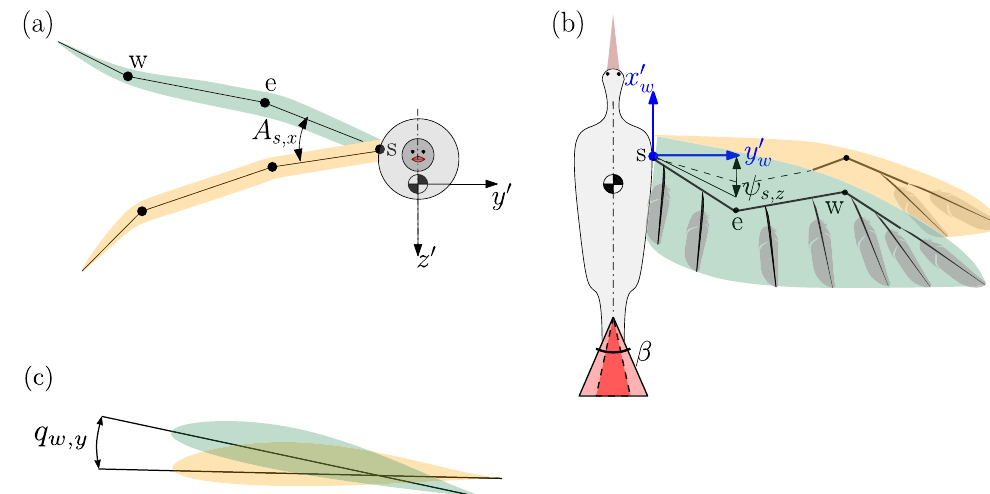
Figure 2. ( a ) Front view of the bird model. The wingbeat amplitude A s , x about the x ′ -axis is the main kinematic parameter governing the wing amplitude of movement. ( b ) Top view of the bird model. The shoulder sweep offset ψ s , z captures the average angle of the arm bone with respect to x ′ w over the period. The angle β captures the magnitude of tail opening. ( c ) Section of the wing. It highlights the wing rotation angle governed by the wrist degree of freedom q w , y